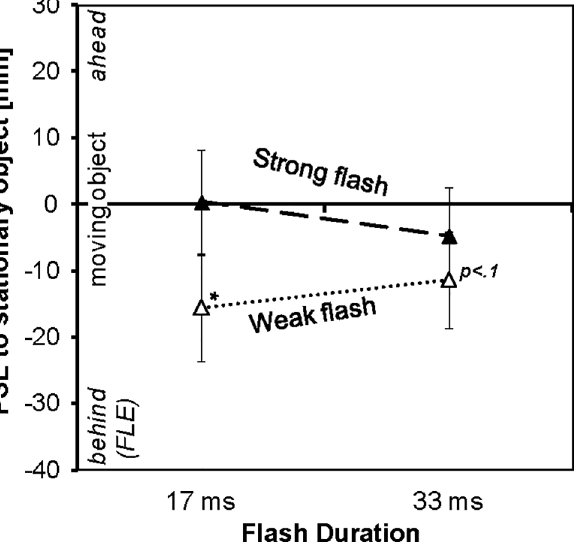
Fig 3. Results, second experiment. Average point of subjectivelyequal position of the moving to the non- moving, stationary object (PSE) computedfrom flash onset position as a function of the intensity and duration of a haptic flash. A significantnegativePSE (asterisk) indicatesa flash-lag effect. Error bars represents standarderrors of the means.